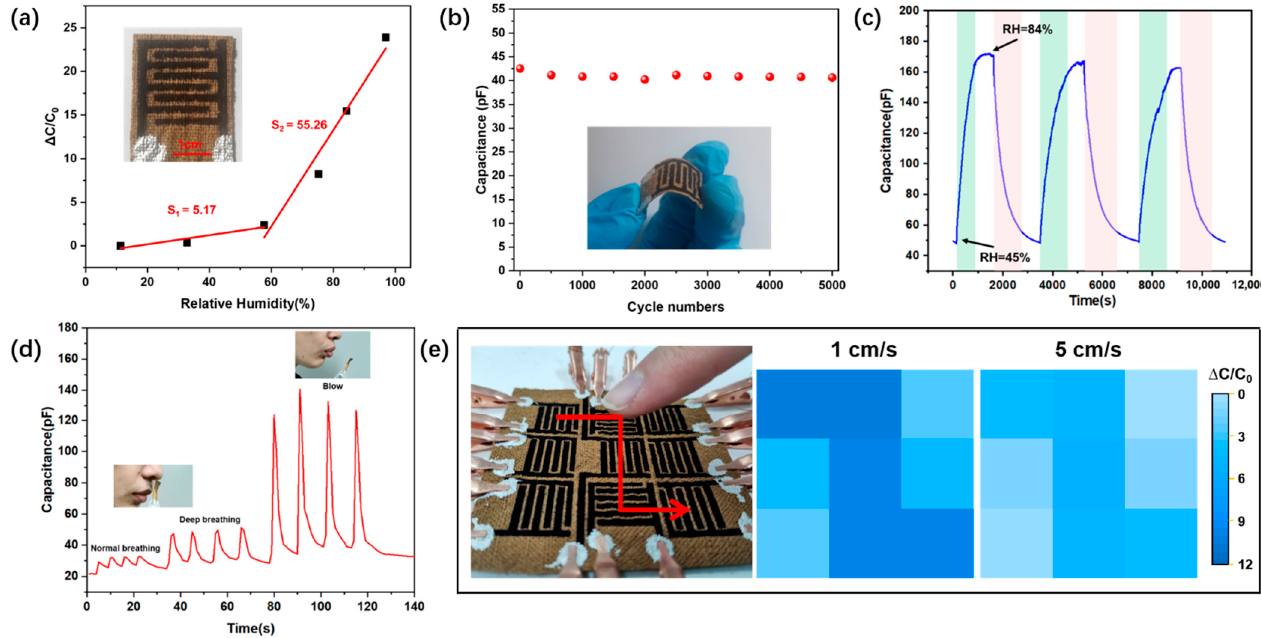
Figure 8. Performance of the sensor for detecting humidity. ( a ) Laser engraved interdigital electrode pattern and its relative capacitance changes as a function of relative humidity. ( b ) Capacitance change of the electrode during application of 5000 bending–unbending cycles. ( c ) Capacitance change of the humidity sensor under alternative humidity change from 45% to 84%. ( d ) Capacitance change of humidity sensor under human blowing and breathing. ( e ) Speed detection of a moving finger using a 3 × 3 humidity sensor array.